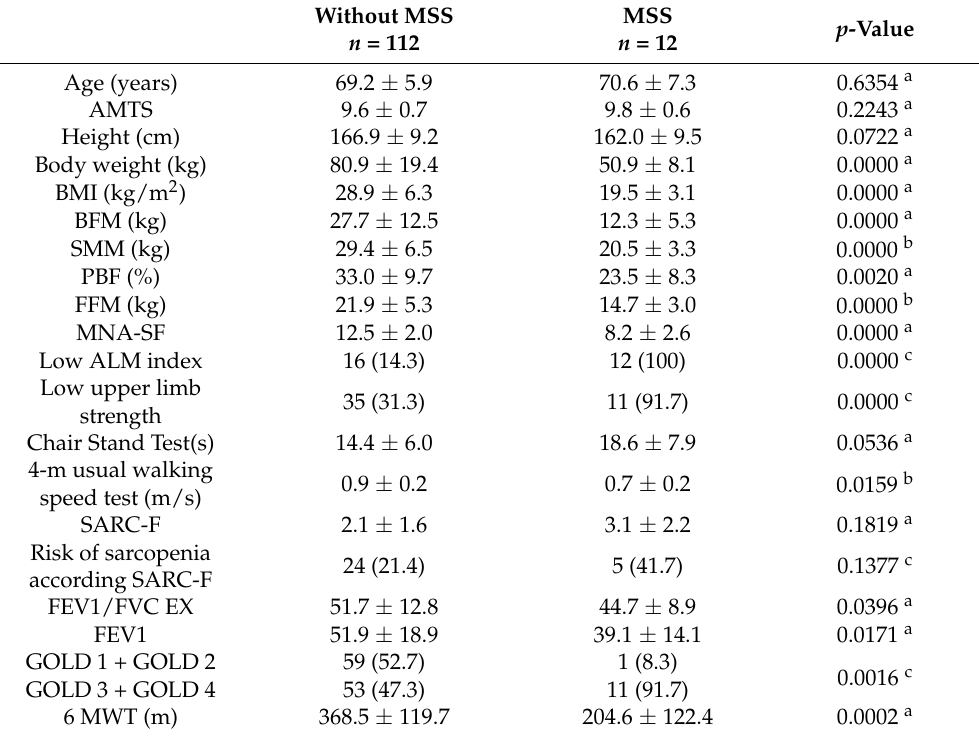
Table 3. Characteristics of subgroups with and without malnutrition-sarcopenia